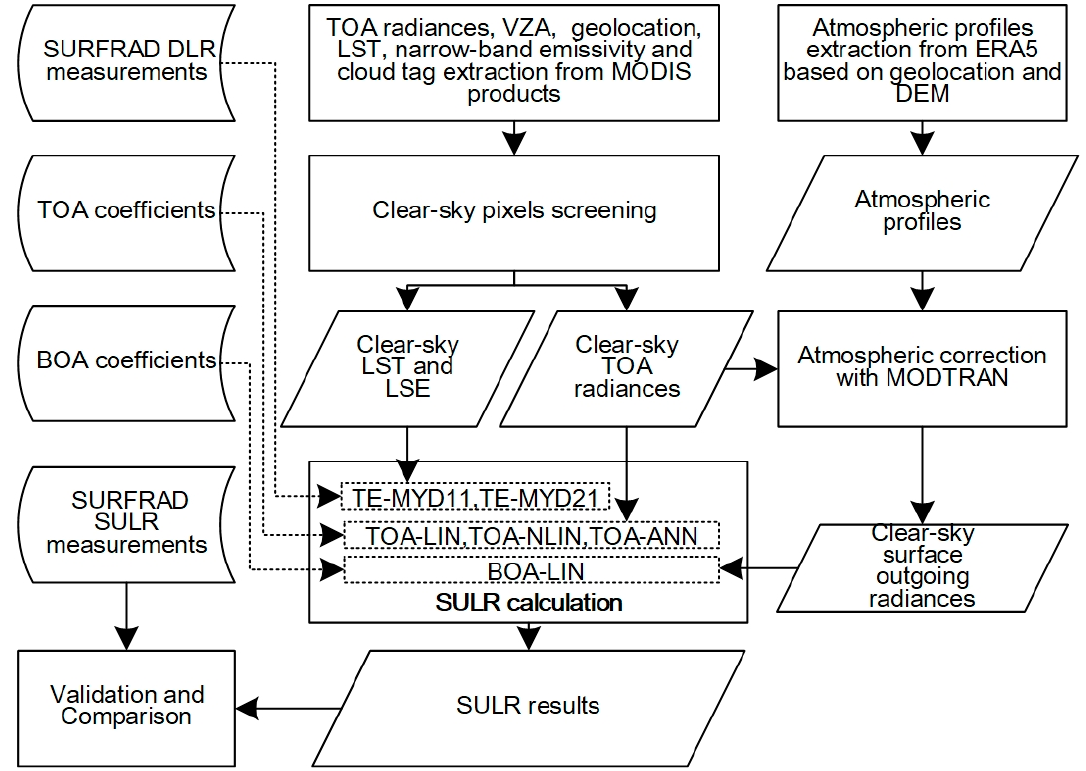
Figure 1. The flowchart of data processing for the Moderate Resolution Imaging Spectroradiometer (MODIS), ERA5, and in situ measurements.